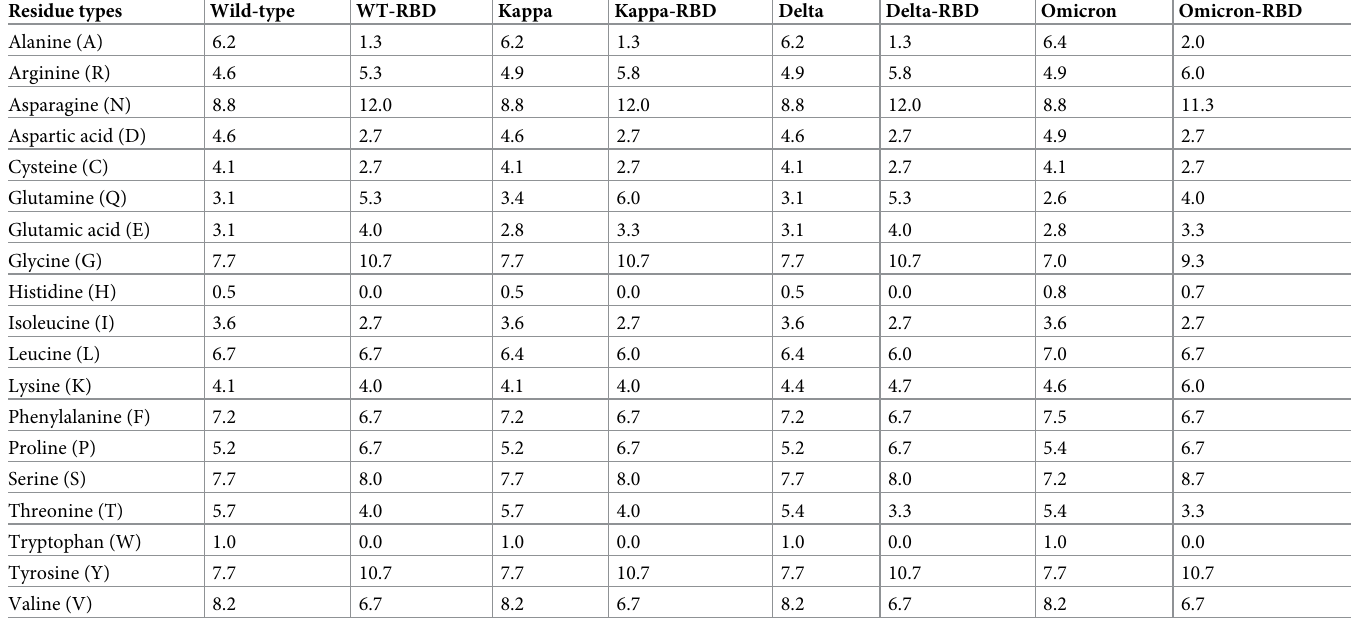
Table 1. Amino acid percentage composition of the mutated SARS-CoV-2 variants with reference to the wild-type in the residue range of 333–526 positions and contact to the RBD